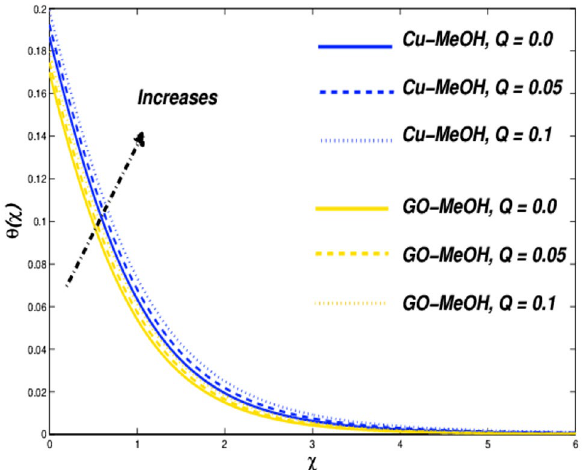
Figure 22. Temperature variation versus Q .